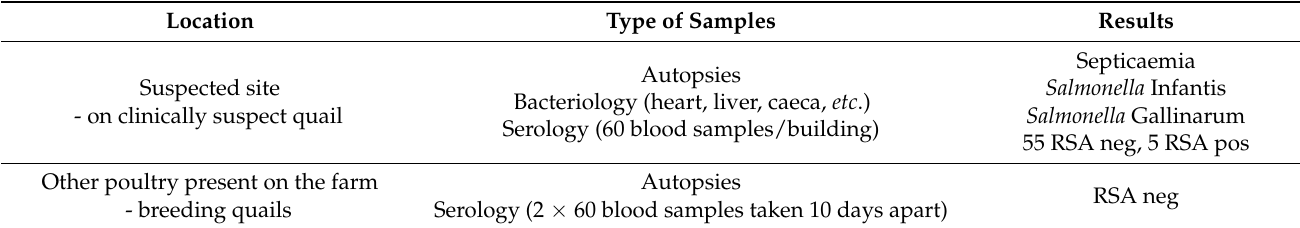
Table 1. Summary of samples taken and serological and bacteriological results obtained. Location Type of Samples Results